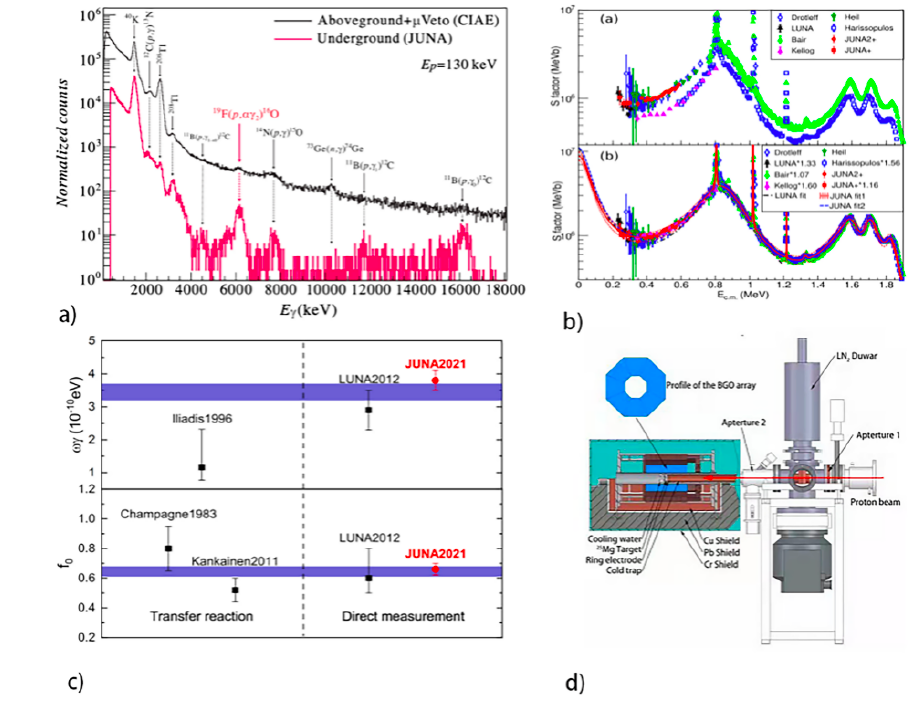
Figure 2. The experiment setup and data analysis a) γ -ray spectra of the 19 F + p experiments measured by a 4 π BGO array at a proton energy of E p = 130 keV. b) The S factor of the 13 C( α ,n) 16 O reaction (a) without and (b) with normalization factors. c) Comparison of recent values of the resonance strength and ground state feeding factor of the 92 keV resonance. d) Schematic diagram of detector setup.